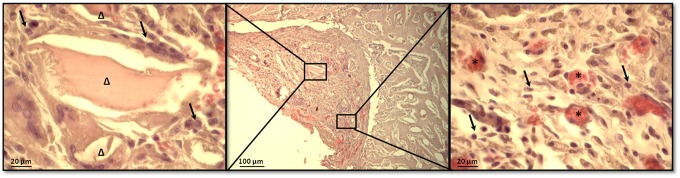
High magnification microscope observations of the femoral lesion filled with DBM-putty after 15 days of implantation.Centre: image at low magnification of DBM-PF127 composite residual occupying part of the defect in which wound healing process is taken over; Right: residual of DBM particles (Δ) at higher magnification; Left: presence of blood vessels (*). Black arrow indicate osteoblast like cells. Section were stained with Hematoxylin/eosin stain after paraffin embedded tissue protocol.